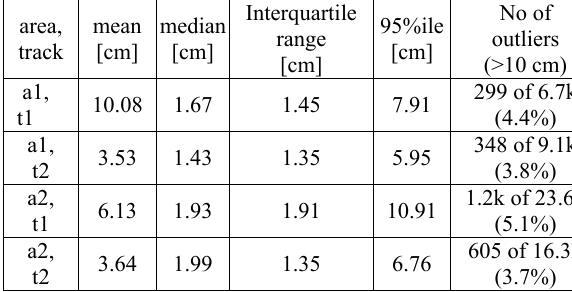
Table 2. Statistics on point-to-model distances for both